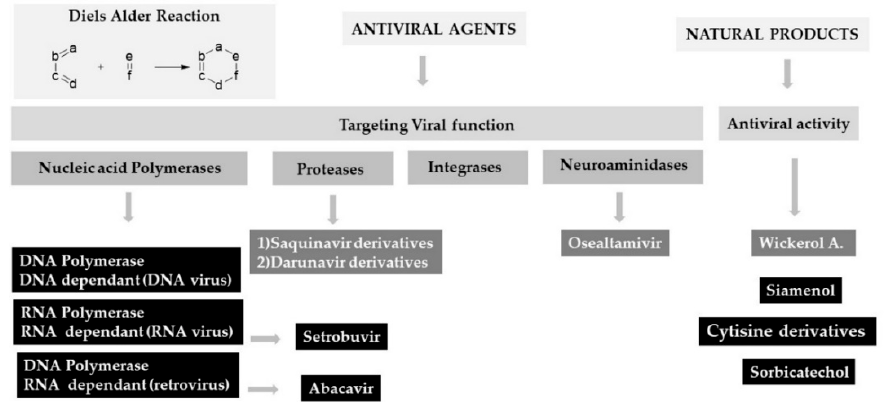
Figure 1. Antiviral agents and natural compounds endowing antiviral activity synthesized by means of DAR.